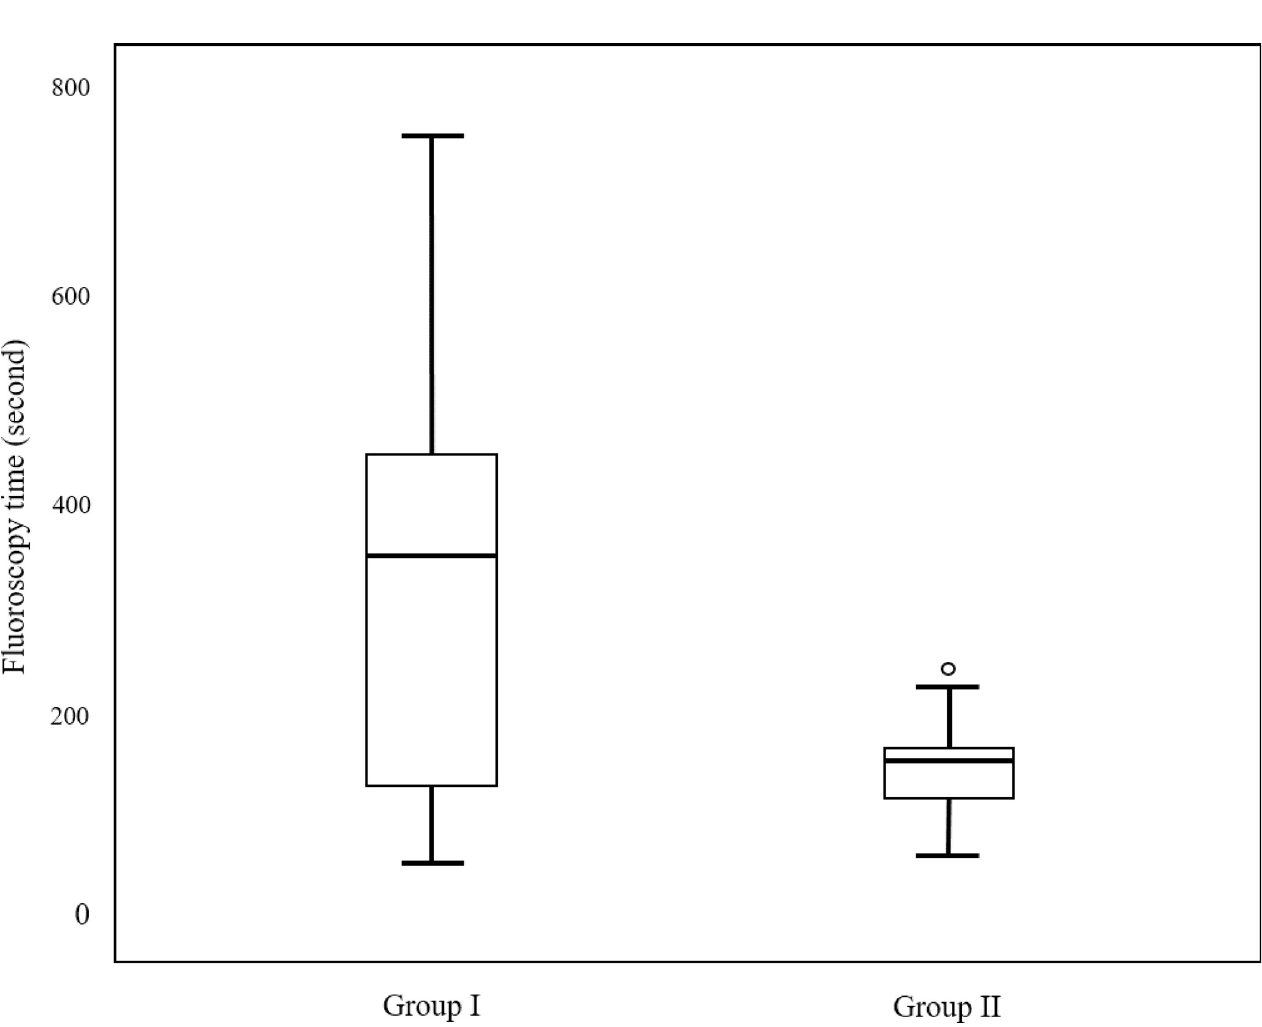
Fig 4. A box and whisker plot comparing the fluoroscopy times between groups I and II. The mean fluoroscopy time was 317 ± 213.6 s in group I and 153.6 ± 54.9 s in group II ( p =